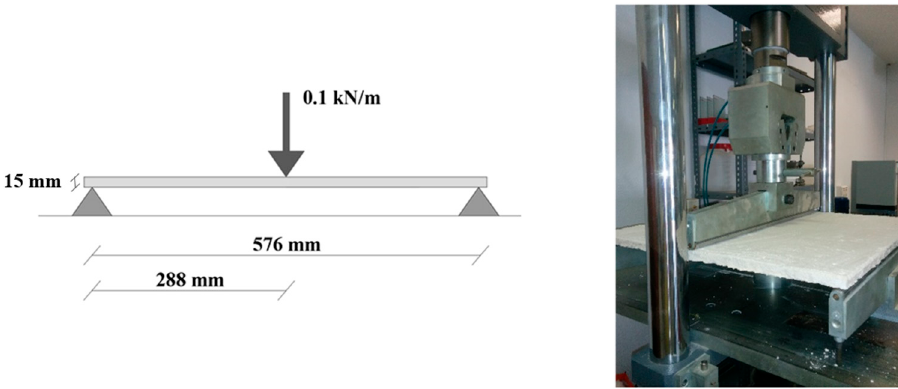
Figure 5. Flexural strength test.